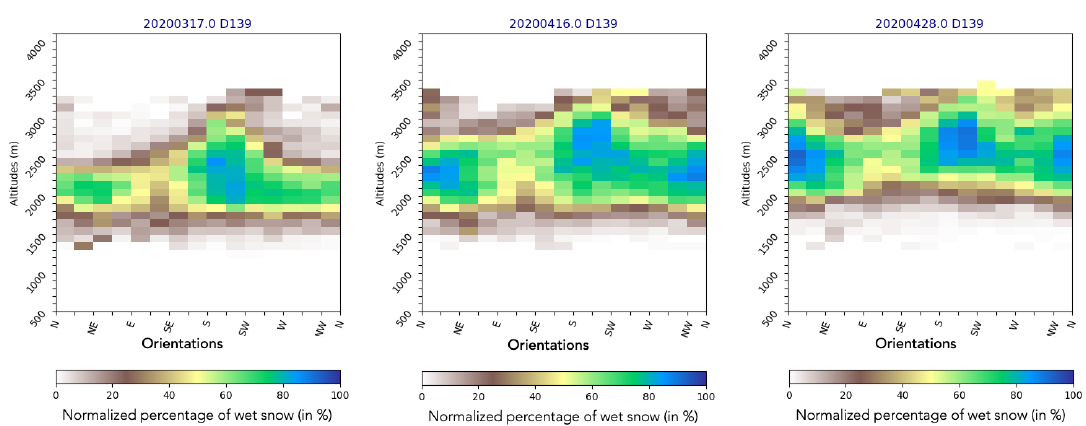
Figure 12. Same as Figure 9 but for spring 2020: 17 March 2020, 16 April 2020 and 27 April 2020.